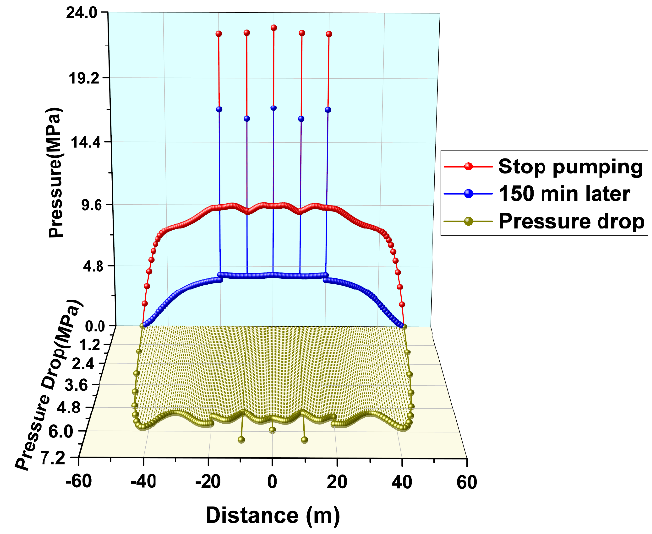
Figure 17. Variation of pore pressure along the central horizontal line. The pressure at the five injection points is always greater than the pore pressure in the nearby reservoir matrix.